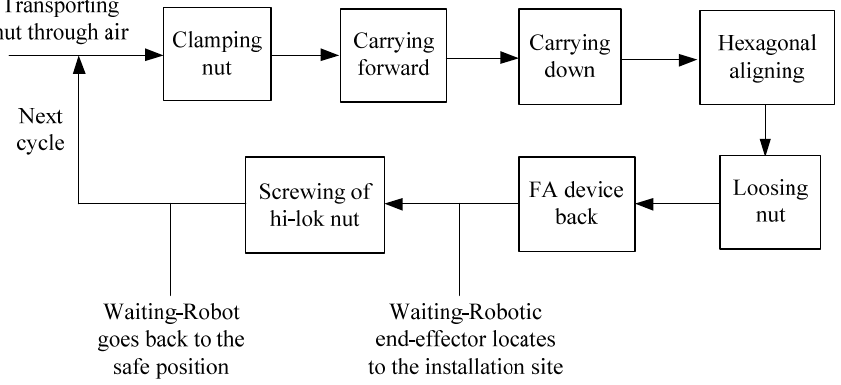
Figure 15. Automation process sequence.